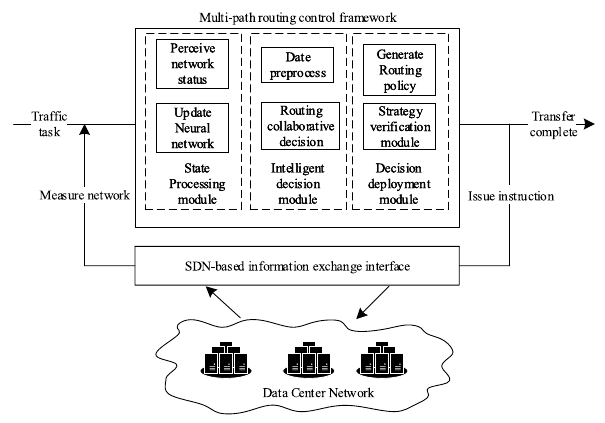
Fig. 6 Routing control mechanism for SAMP